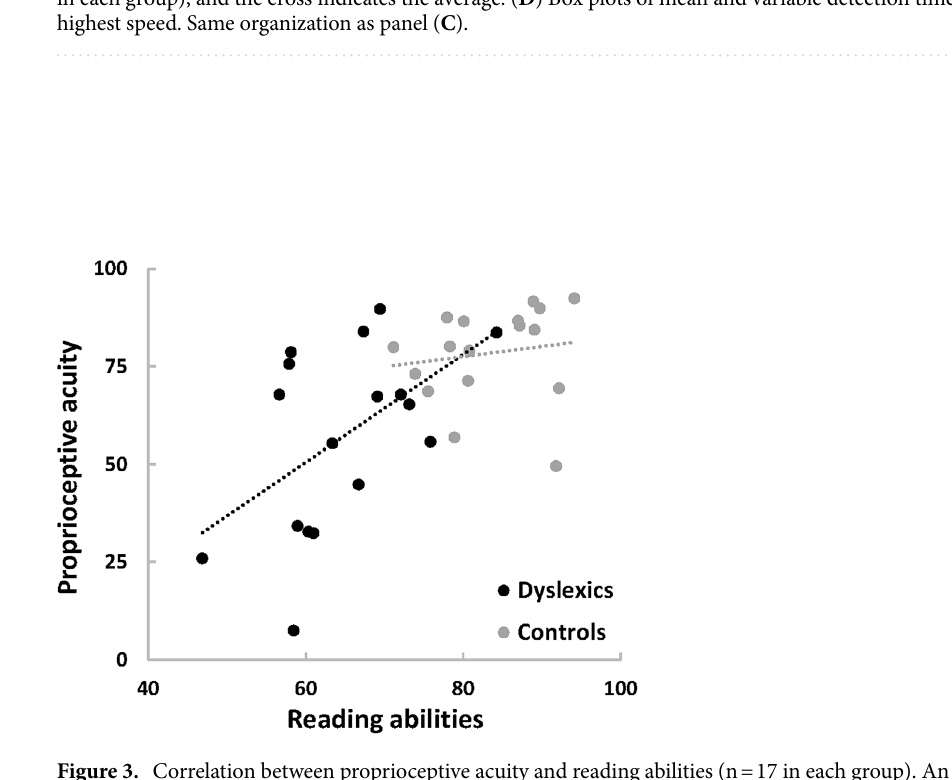
Figure 3. Correlation between proprioceptive acuity and reading abilities (n = 17 in each group). An index representing proprioceptive acuity (vertical axis) was computed as the normalized average of Mean and variable detection time at the slowest speed. An index representing reading abilities (horizontal axis) was computed as the normalized average of four clinical scores that are routinely used to diagnose developmental dyslexia (see Methods). Dashed lines depict linear regressions for each